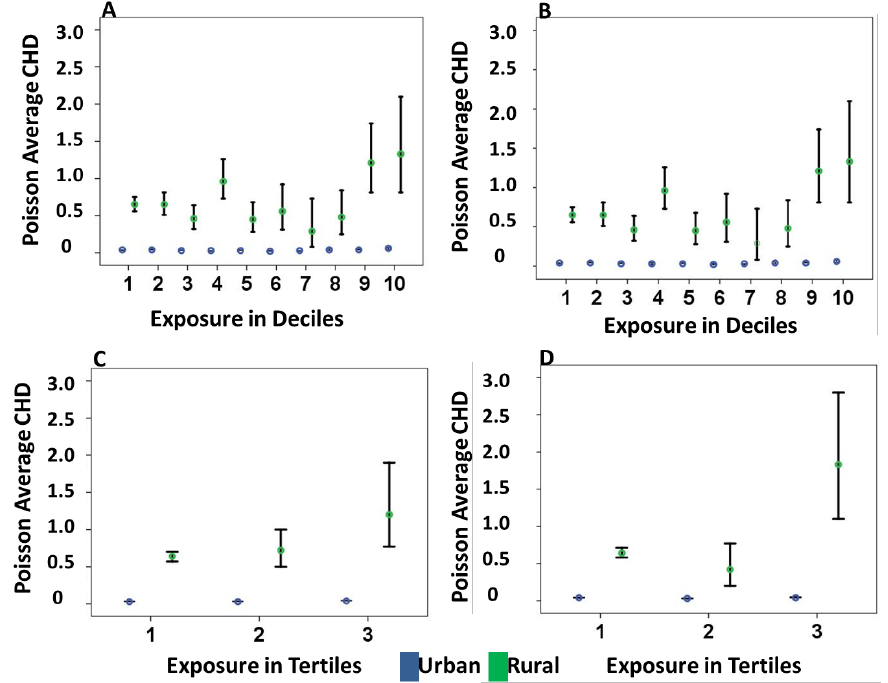
Figure 2. Distribution of the Poisson average of congenital heart defect (CHD) cases and 95% confidence intervals (CI) in urban and rural postal codes exposed to the percentile categories of inverse distance weighted (IDW) emissions. Rural postal codes had a larger average and variability of CHD cases per postal code in all the deciles for the sum of all emissions ( A ) and Group 1 emissions ( B ). The overall distributions in both Figures 2A,B were similar, and in urban postal codes, the average and variability were constant. For Group 2 ( C ) and Group 3 emissions ( D ), the average and variability of CHD cases by postal code was high in rural compared to urban postal codes, with the highest average in the 3rd tertile where the exposure was the highest.